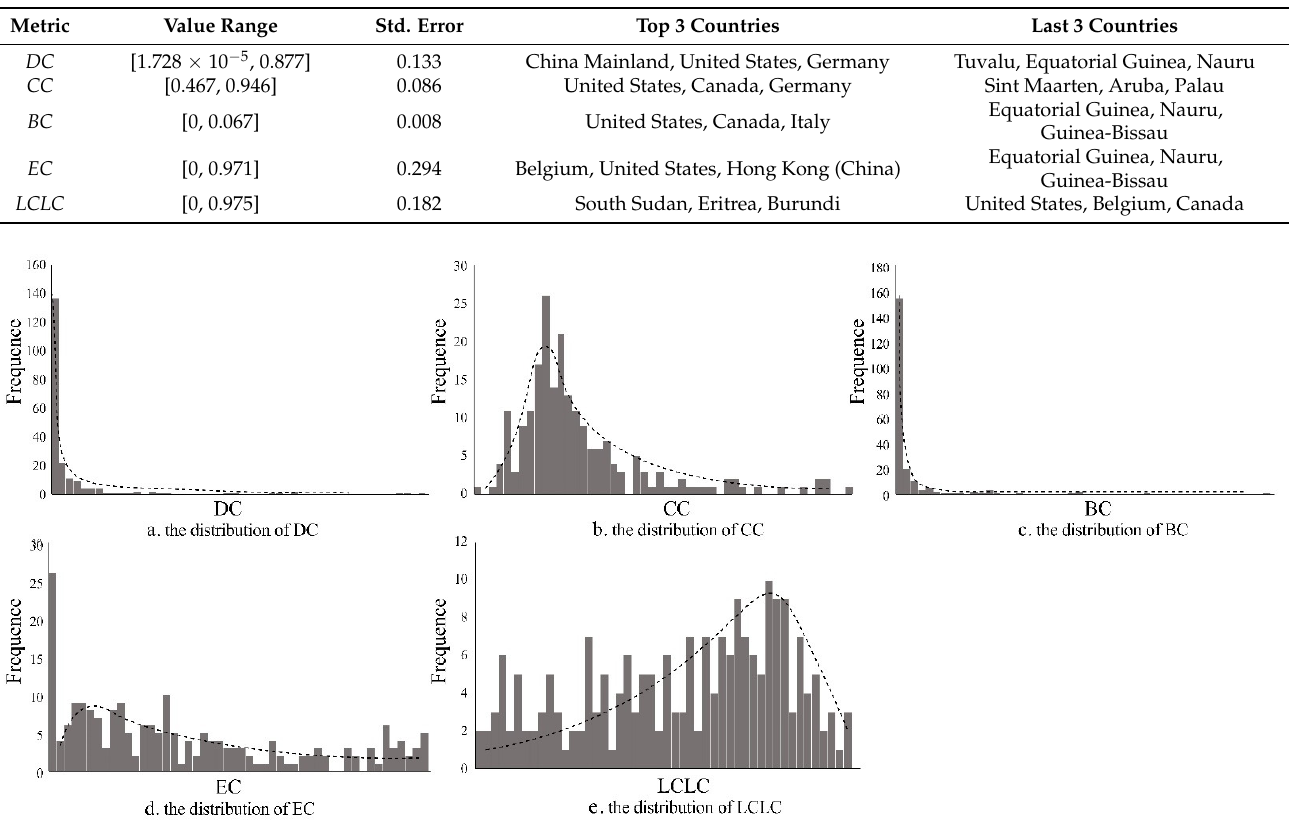
Table 3. The correlation coefficients between the global measurements and performance